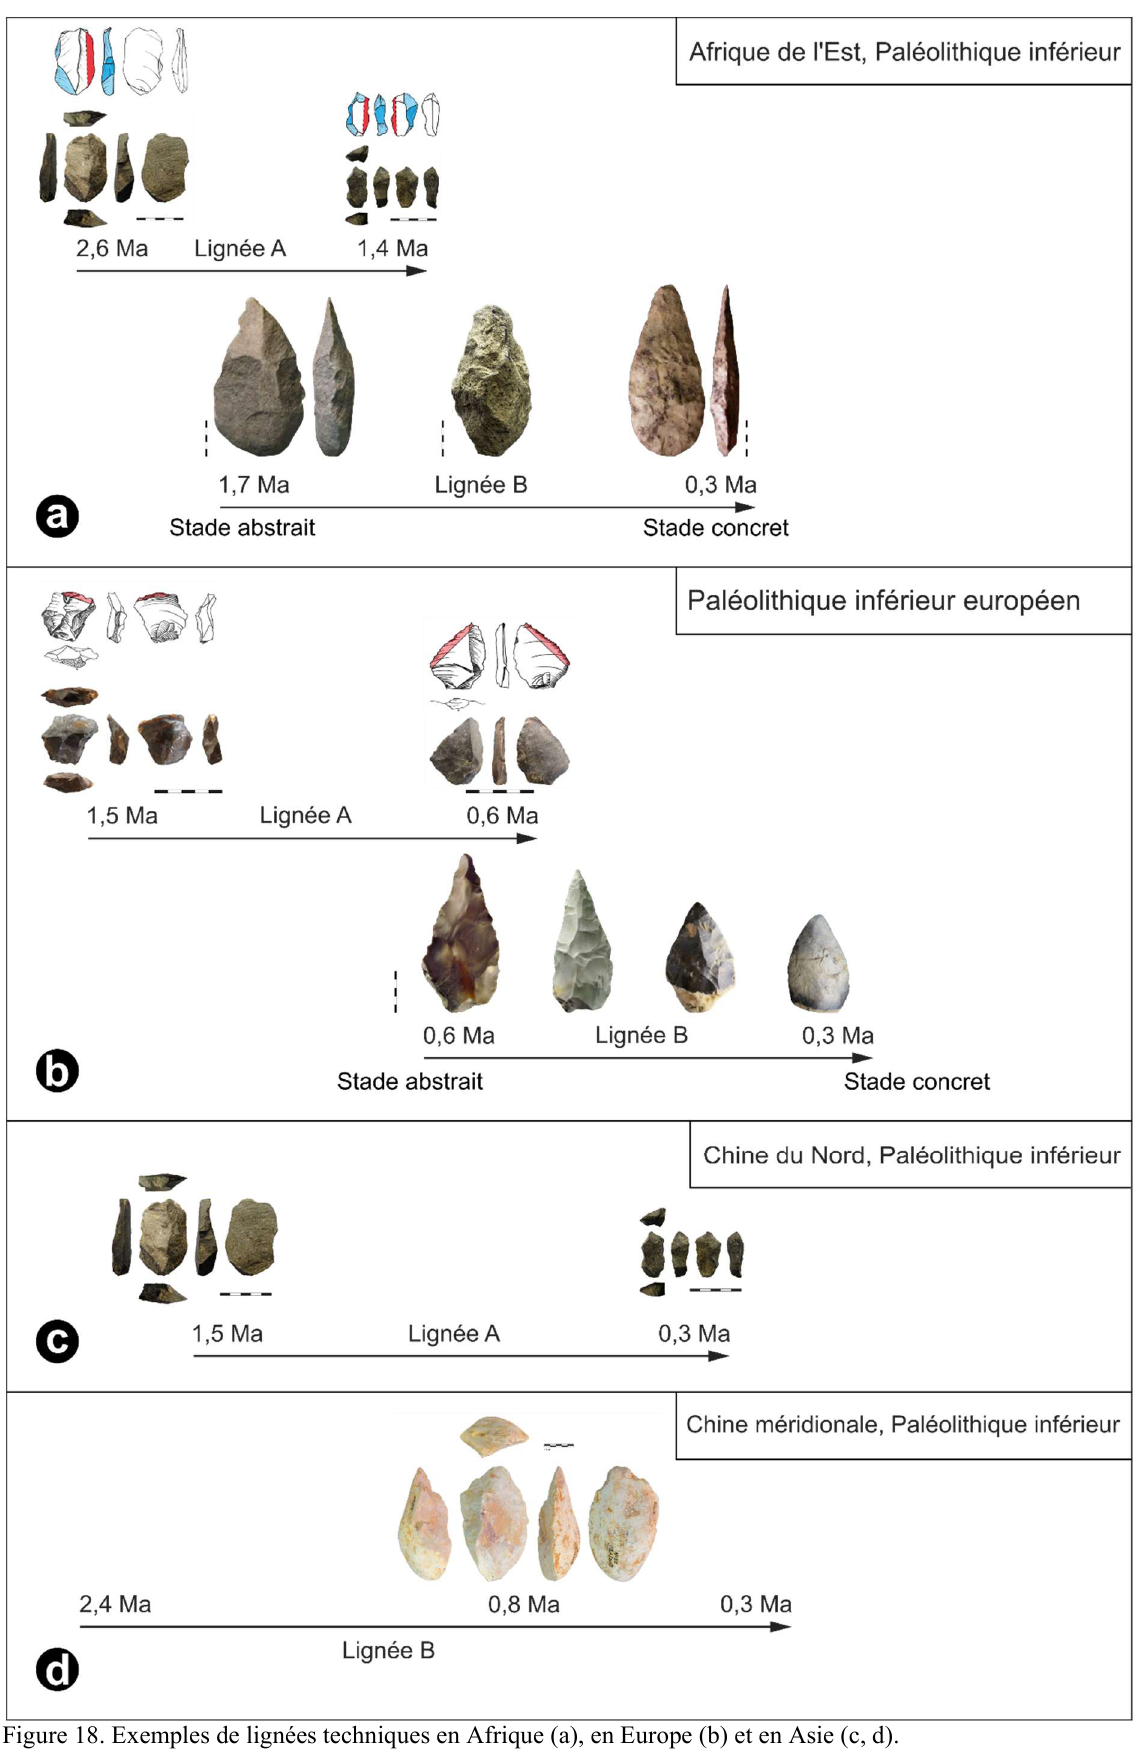
Figure 18. Exemples de lignées techniques en Afrique (a), en Europe (b) et en Asie (c,